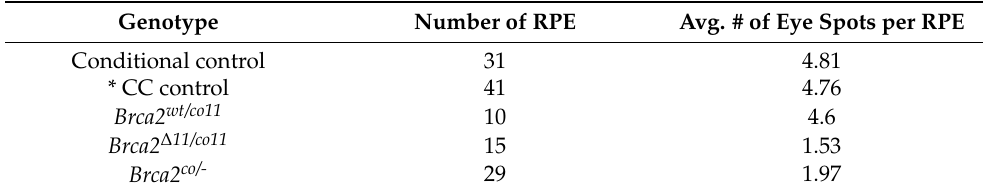
Table 1. Summary of RPEs examined and p un reversion frequency by genotype. Data represented are from the blue, >80% stain (Cre activity) samples. * The combined conditional (CC) control is the combination of the conditional control ( Trp1-Cre ) controls with Brca2 wt/co11 . The number of RPEs are the actual number of RPEs we examined, and the average number of eye spots per RPE is derived from the total number of eye spots divided by the number of RPEs